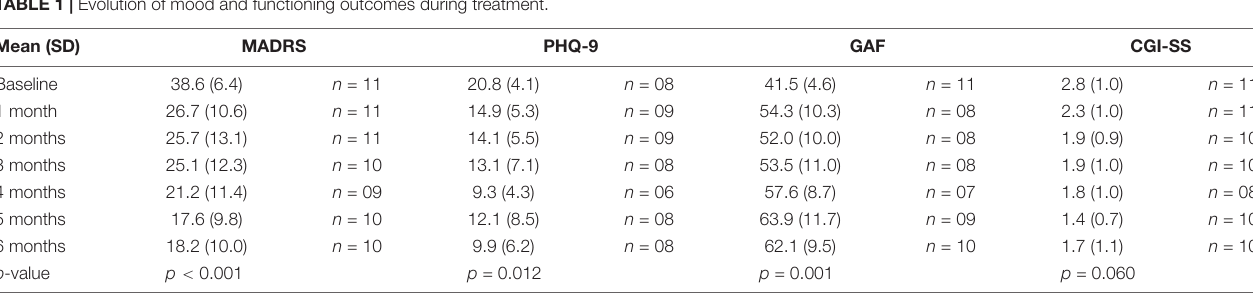
FIGURE 1 | The evolution of depressive symptoms (through MADRS and PHQ-9) and global functioning (through GAF) during treatment. MADRS, Montgomery-Åsberg Depression Rating Scale; PHQ-9, Patient Health Questionnaire-9; GAF, Global Assessment of Functioning. The main figure (on the left) shows MADRS scores for individual participants. The two figures on the right report means and standard deviations for PHQ-9 and GAF. TABLE 1 | Evolution of mood and functioning outcomes during